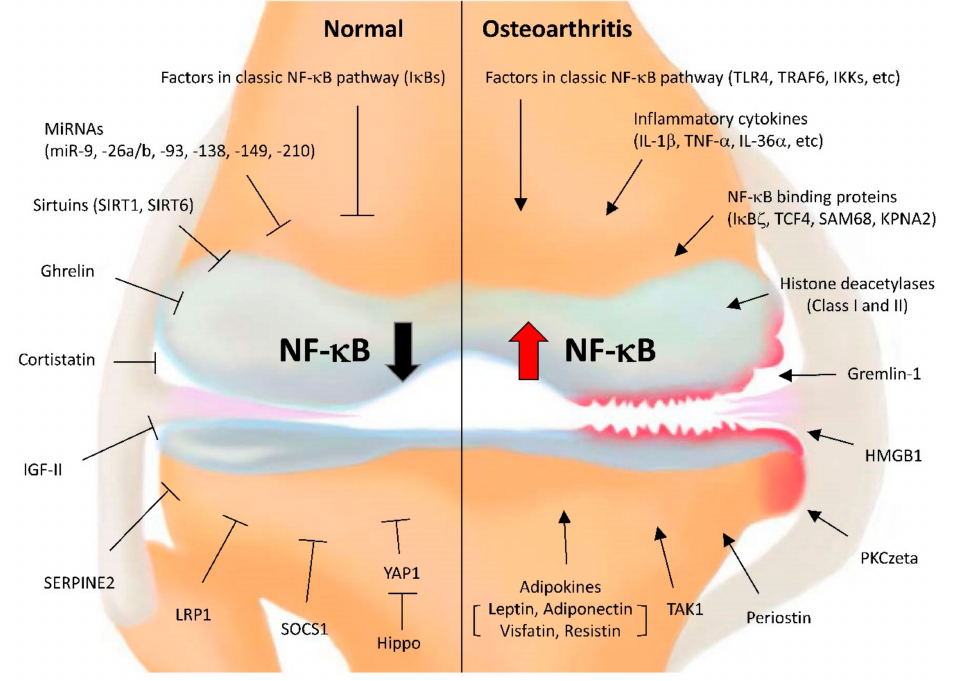
Figure 1. The genes or signaling pathways that positively or negatively regulate NF- κ B activation in chondrocytes. In normal chondrocytes, several factors contribute to cartilage homeostasis by maintaining NF- κ B activity at a basal level ( left ). In response to OA stimuli, the factors indicated stimulate NF- κ B activation, leading to the induction of matrix-degrading enzymes and inflammatory or destructive mediators, eventually causing cartilage destruction ( right